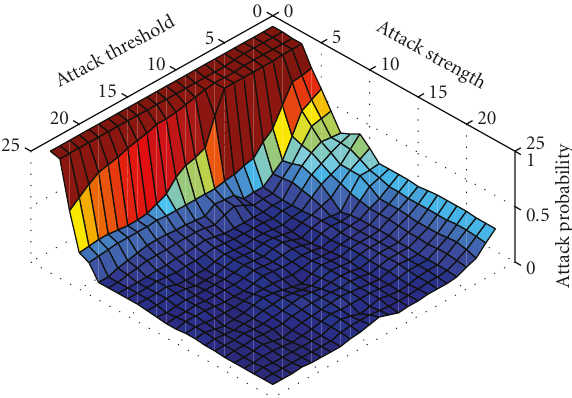
Figure 14: Region that detection is